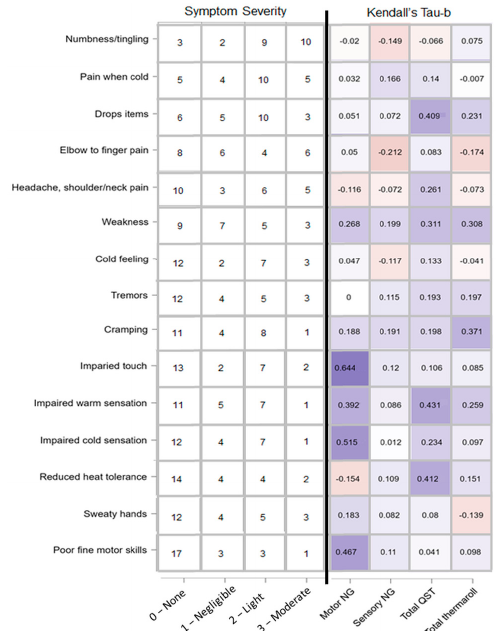
Figure 12. Reported symptom severity and correlation with amount of clinically relevant cases